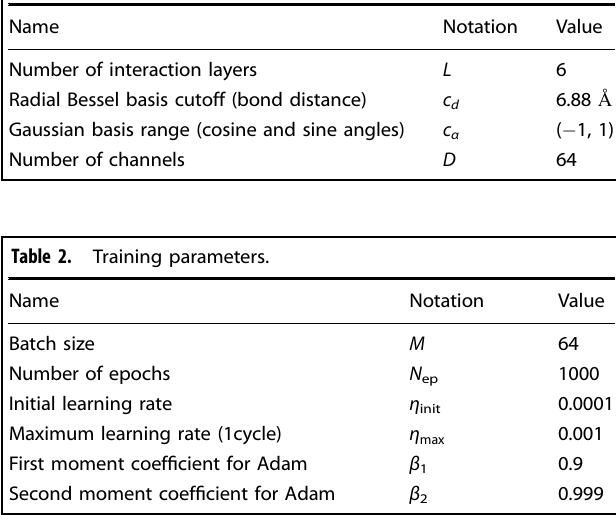
(Table 2). All other parameters, if unspeci fi ed in this work, default to values per PyTorch 1.8.1 and PyTorch Geometric 1.7.2. DATA AVAILABILITY